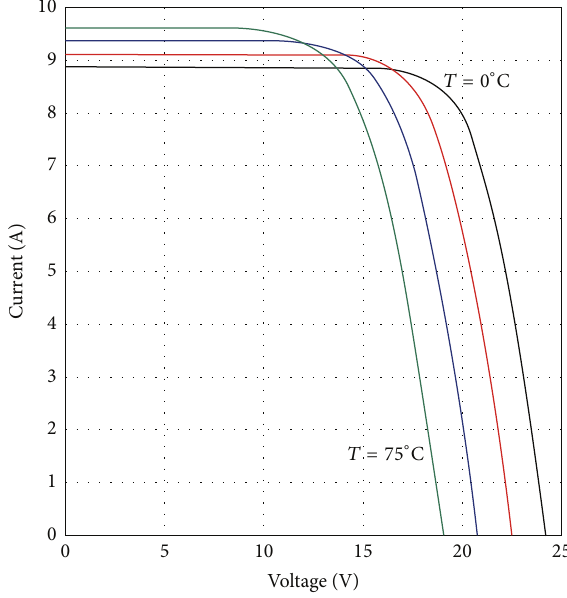
Figure 14: Matlab model 𝐼 - 𝑉 curves for various temperatures (BSM-150, 𝐺 = 1000 W/m 2 , 𝑇 = 0 , 25, 50, 75 ∘ C).